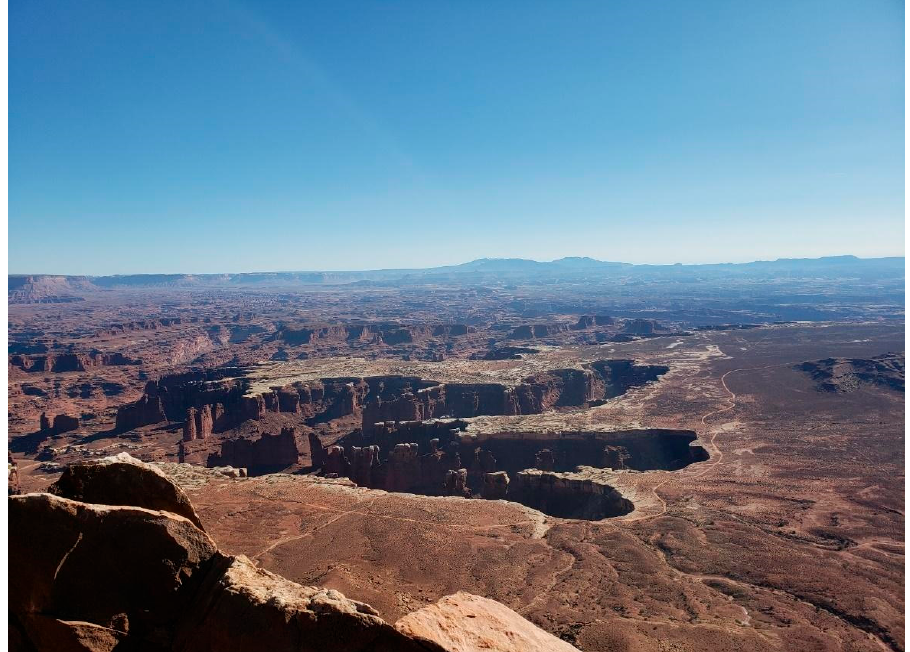
Figure 3. Grand View Point, Canyonlands National Park. Photograph by Natalie S. Mumich, November 2018.